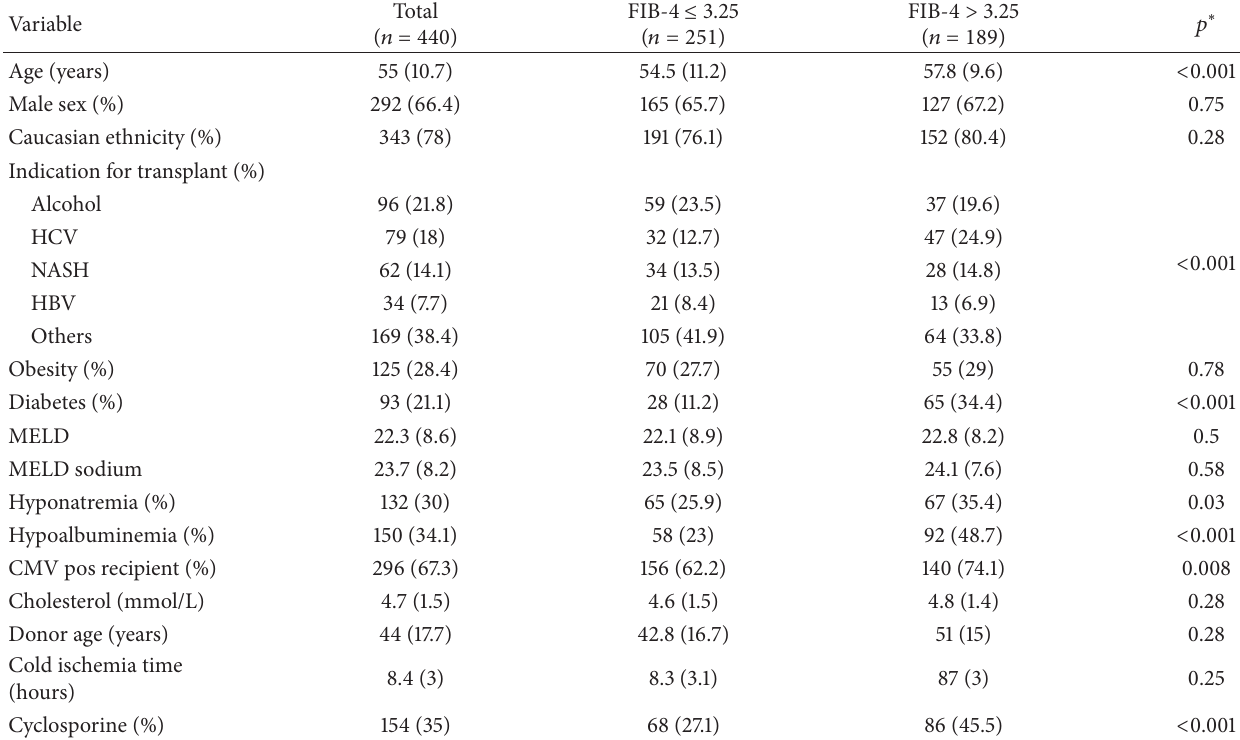
Table 1: Baseline sociodemographic and clinical characteristics of study population by outcome